Question: Based on the figure, does the quantity rise or fall?
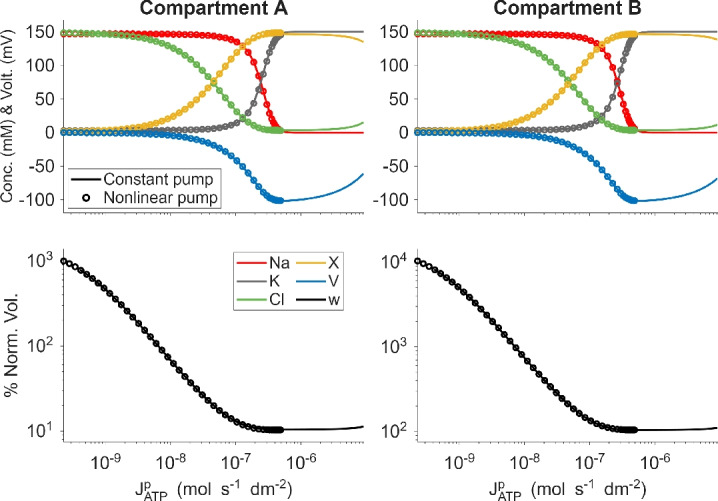
Answer: increasing